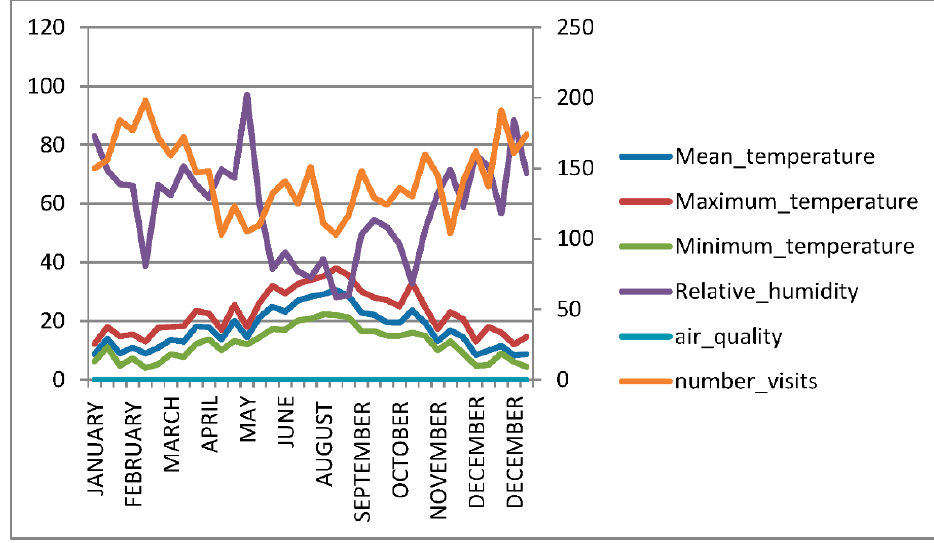
Figure 4. Relationship between the attribute target and predictors for working days.